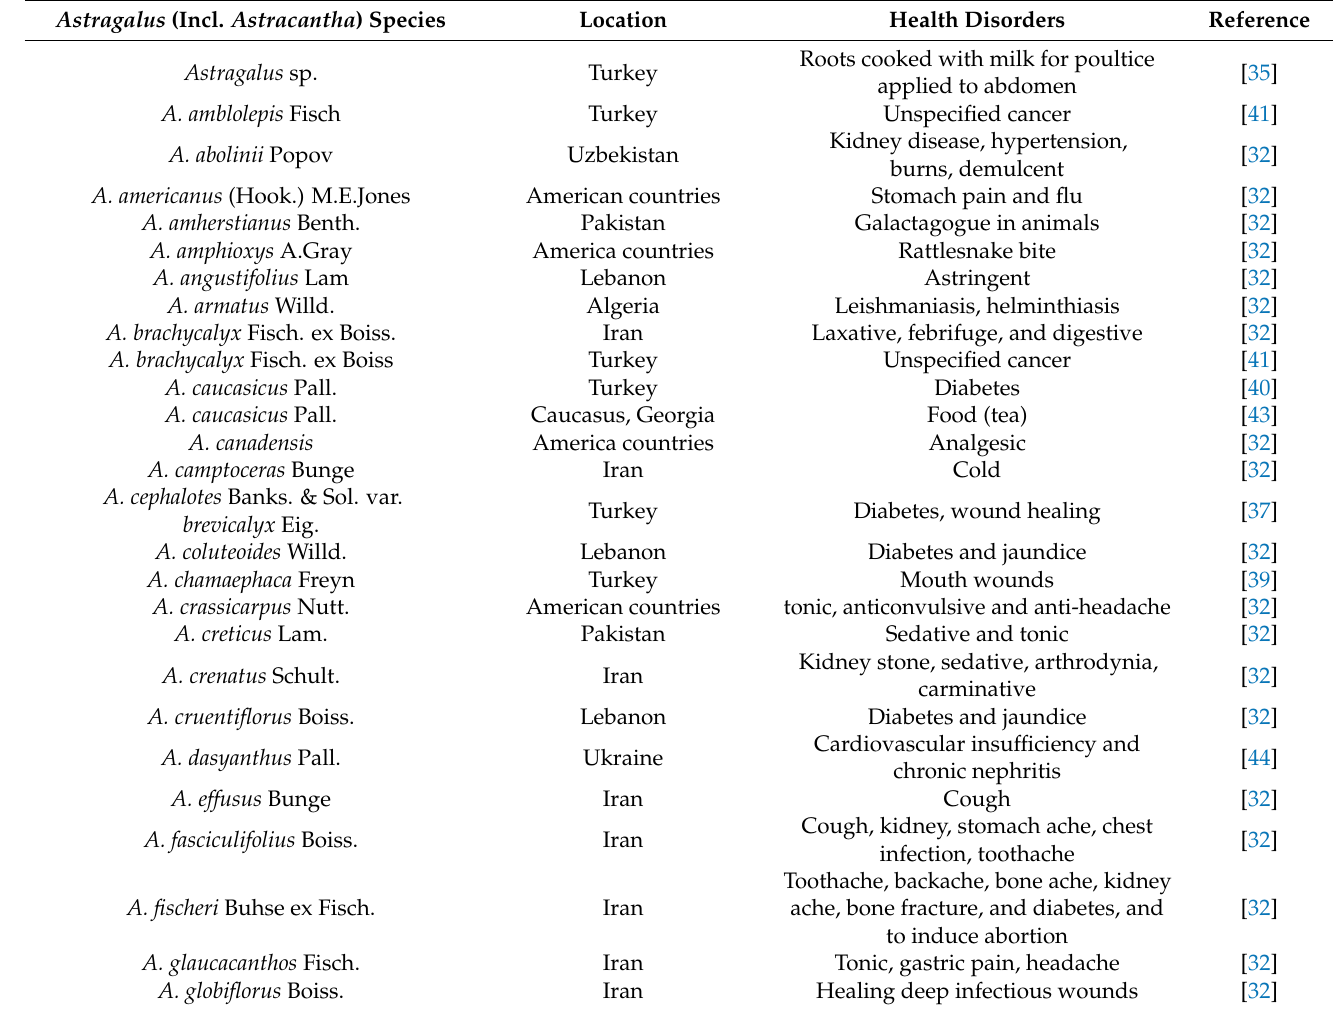
Table 1. Ethnobotanical use of Astragalus